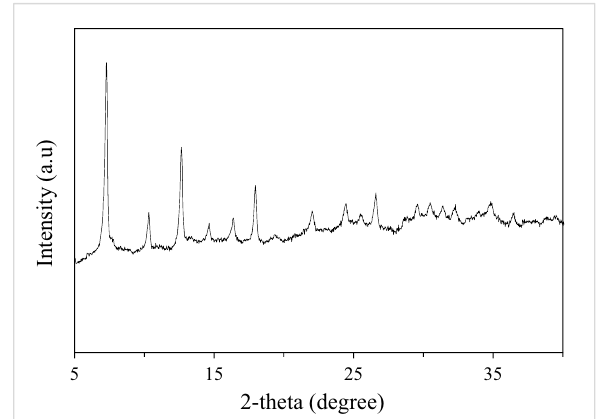
Figure A1: PXRD of CuCo - ZIFs.